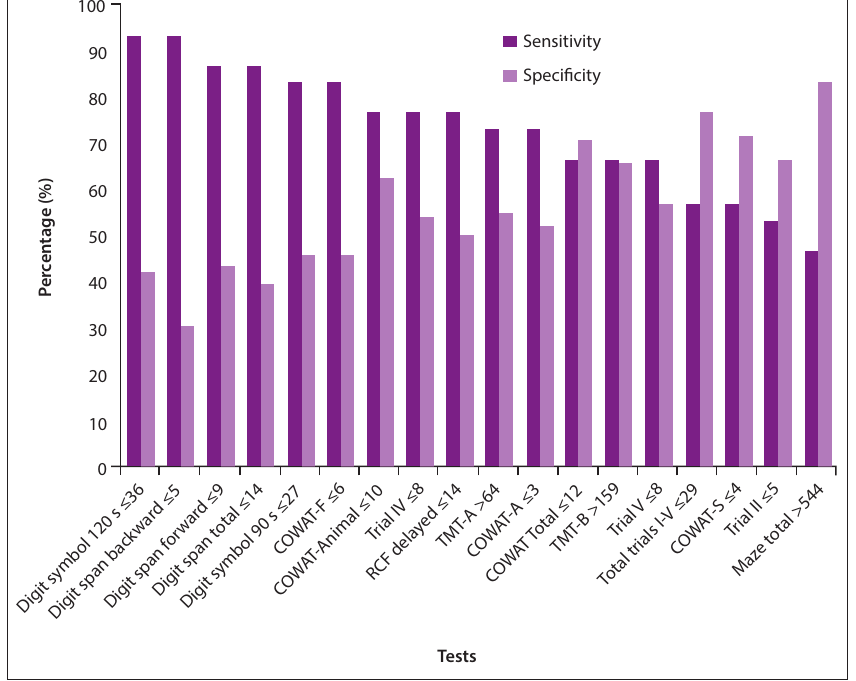
Fig. 2. Optimal sensitivity and specificity of tests for MCI v. controls. (COWAT = controlled oral word association test; RCF = Rey complex figure; TMT = trail making test; MCI = mild cognitive